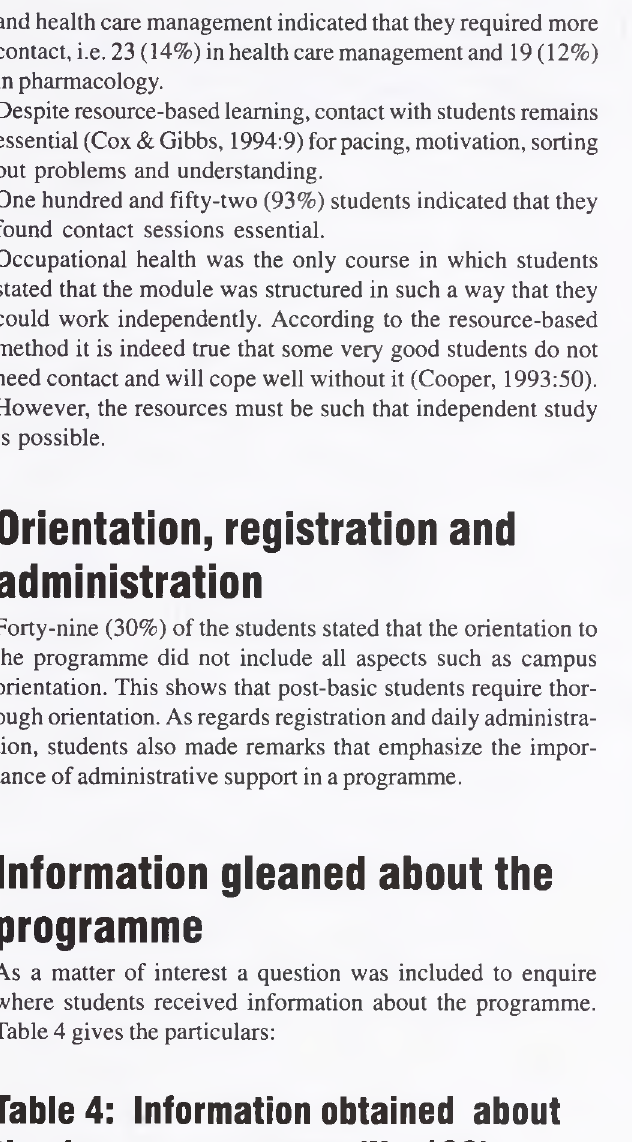
the degree programme